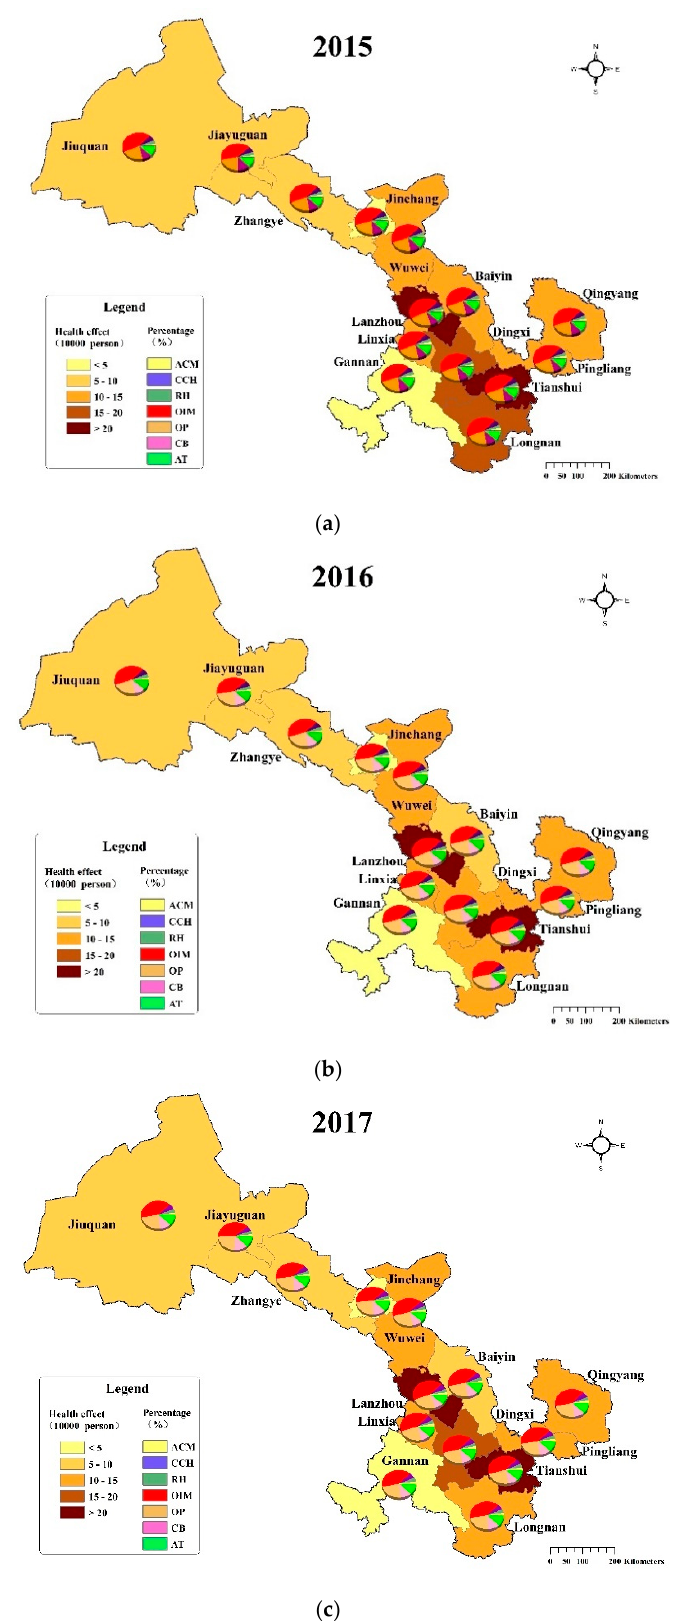
Figure 4. Health e ff ects related to PM 2.5 in 14 cities in Gansu Province from 2015 to Figure 4. Health effects related to PM 2.5 in 14 cities in Gansu Province from 2015 to 2017. For different health endpoints, the proportion of health endpoints in overall health effects in 14 cities was similar. Compared with other health endpoints, the proportion of outpatient visits to